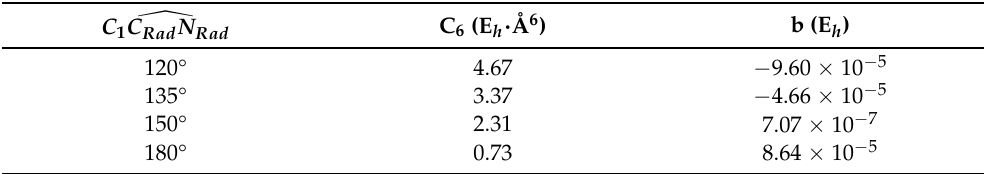
Figure 2. Curves of the intermolecular potential V Entrance (in kJ · mol − 1 ) representing the initial (cid:92) C 1 C Rad N Rad angles (in degrees). bimolecular approach at different Table 2. Values of C 6 and b of Equation (5). The linear fitting was carried out with values of V Entrance for d C = [4;12] Å. Note that 1 E h = 2625.500 kJ · mol − 1 1 -C Rad